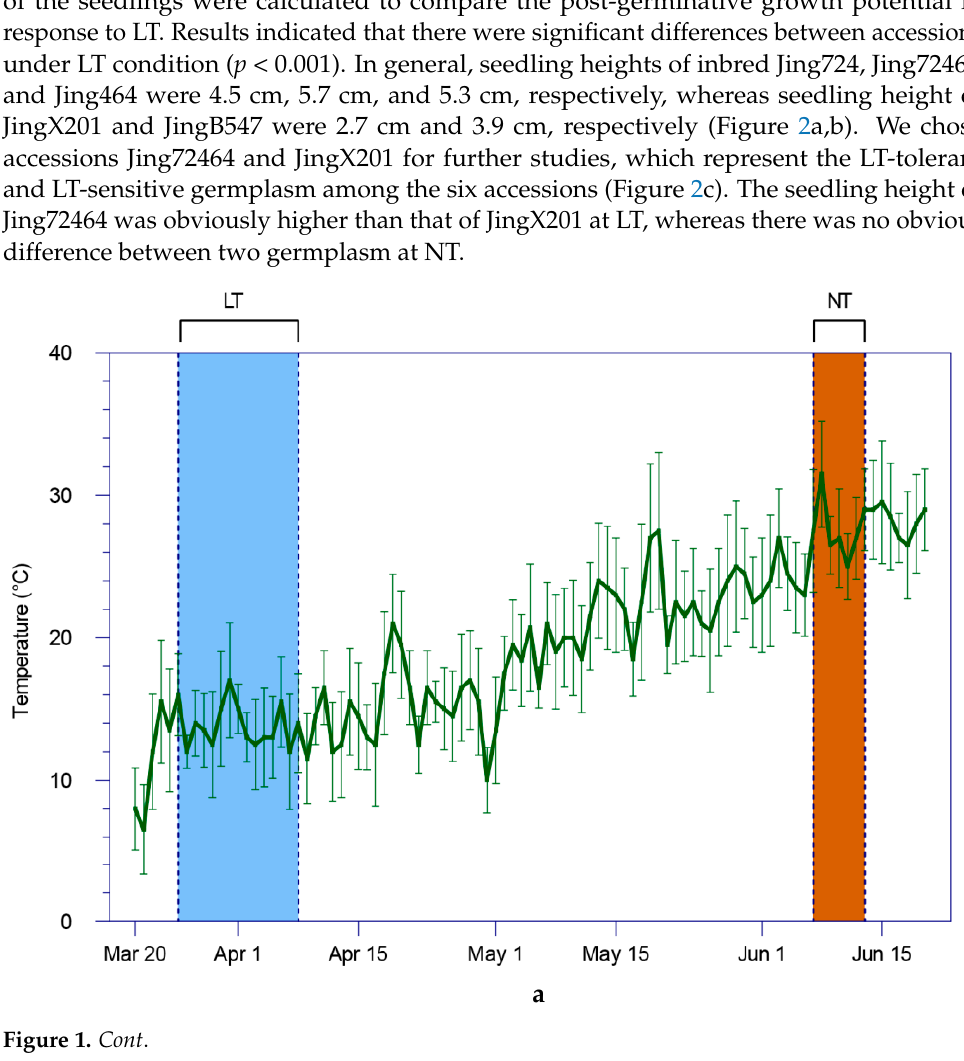
Figure 1. Germination rate of different elite maize inbred accessions under low tempera- ture ( a ) Daily average temperature (green line) from 20 March to 20 June in the field where experiment conducted. The color-filled zone indicated the duration time after sowing when 5 percent coleoptile of Jing72464 emerged from the soil. Blue color zone indicated low temperature (LT) condition that seeds were sowing in early spring, while brown color zone indicated normal temperature (NT) condition that seeds were sowing in summer. ( b ) Germination rate of 6 maize inbred accessions in the filed condition under LT or NT. Data represent mean values of three independent replicate ( n > 1000). ( c ) Inhibition rate of LT on seed germination. Inhibition rate was calculated as the germination rate in LT ver- sus that in NT. Significant differences in ( b , c ) were labeled with different Roman (a, b) or Greek letters ( α , β ).